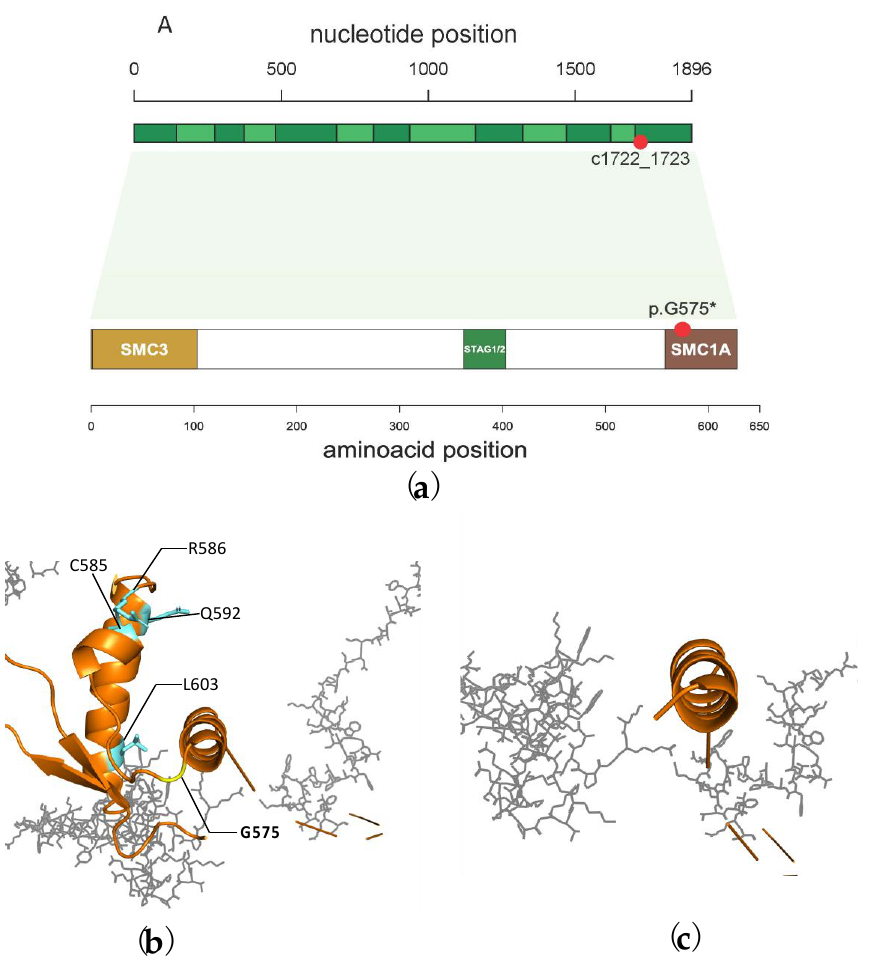
Figure 4. In silico prediction of RAD21 p.Gly575SerfsTer2. ( a ) The frameshift variant occurs in the last exon of the coding sequence (Consensus Coding Sequence ID: CCDS6321.1, top), and is predicted to form a stop codon two residues downstream, in the SMC1A domain (bottom). ( b ) C-terminal moiety (last 80 residues, orange) of Rad21 wild type ( b ) or truncated ( c ) at position 577. In cyan, some residues important for Smc1A interaction [13]. The residue involved in the frameshift (Gly575) is depicted in yellow.